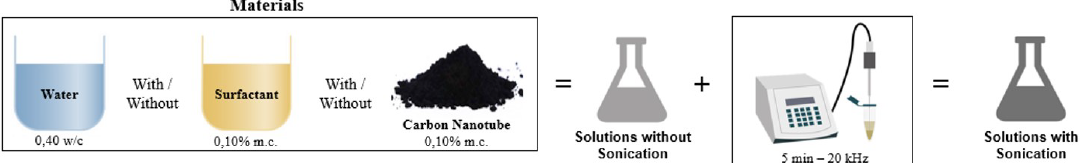
Figure 3. Preparation of solutions containing water, surfactants, and carbon nanotubes with and without the application of ultrasonication.